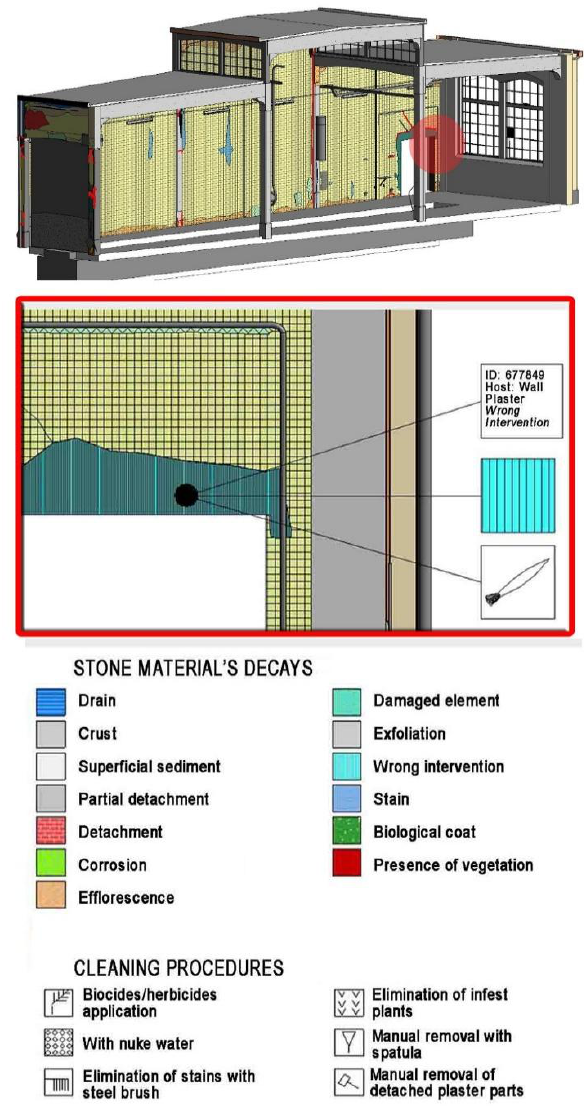
Figure 6. 3D Modeling of decays and the graphic explanation of the data (through labels) associated to the adaptive component, such as the nature of the decay and the interventions required for